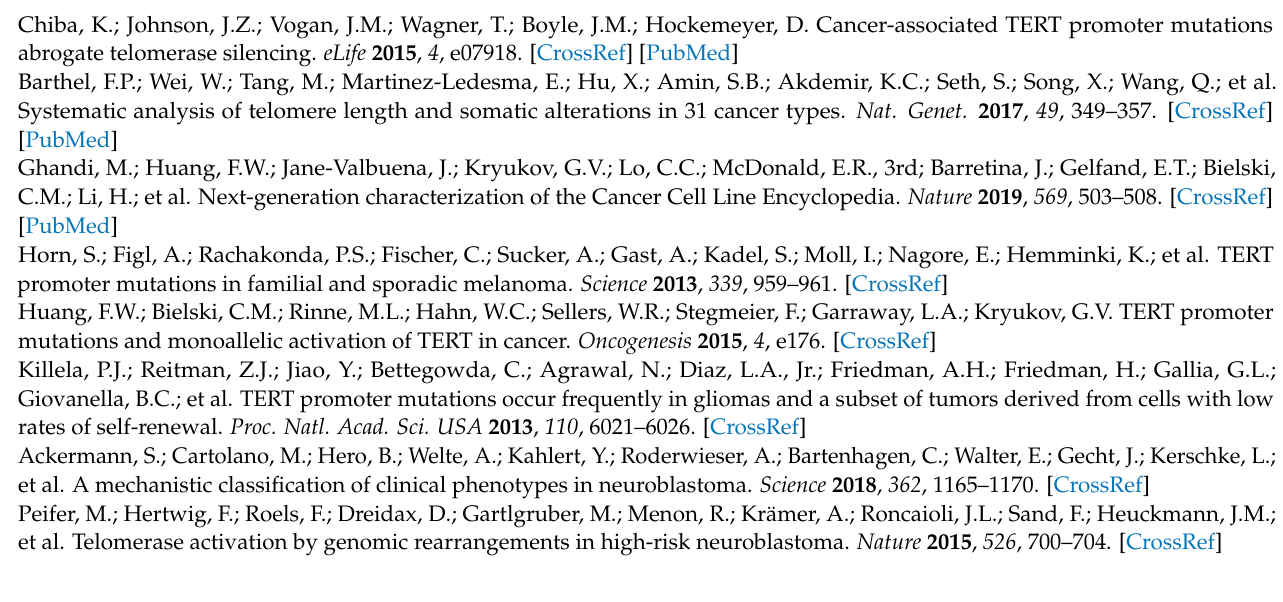
purely according to the methylation profiles of the long reads. Figure S6: Decitabine treatment affects H19 RNA expression in cancer cell lines. (A) H19 RNA levels were measured in DMSO or DAC-treated wild-type cell lines by RT-qPCR. TATA-binding protein mRNA levels were used for normalization. cDNA was prepared from cells treated with either DMSO or DAC, as in Figure 4. Results of one experiment are shown. (B) H19 RNA levels in DMSO or DAC-treated mutant (WM-88, UMUC3, and WM-46) and rearranged (WM-51) cell lines were measured, as in panel A. Results of two (UMUC3 and WM-88) or one (all other cell lines) biological replicate experiments are shown. Three technical replicate measurements were made for each sample. Error bars indicate standard deviation. Table S1: Cancer cell lines ( TERT promoter mutation, methylation and rearrangement assessment). Table S2: Melanoma histology, TERT promoter mutation, methylation and rearrangment assessement and TERT expression measurements. Table S3: DMSO- and DAC-treated cancer cell line TERT promoter methylation measurements. Table S4: Cancer cell lines TERT allele-specific expression (ASE) measurements. Table S5: DMSO- and DAC-treated cancer cell lines TERT allele-specific expression (ASE) measurements. Table S6: Genomic location (hg19) of TERT promoter characterized in the literatures and CpG sites used in this